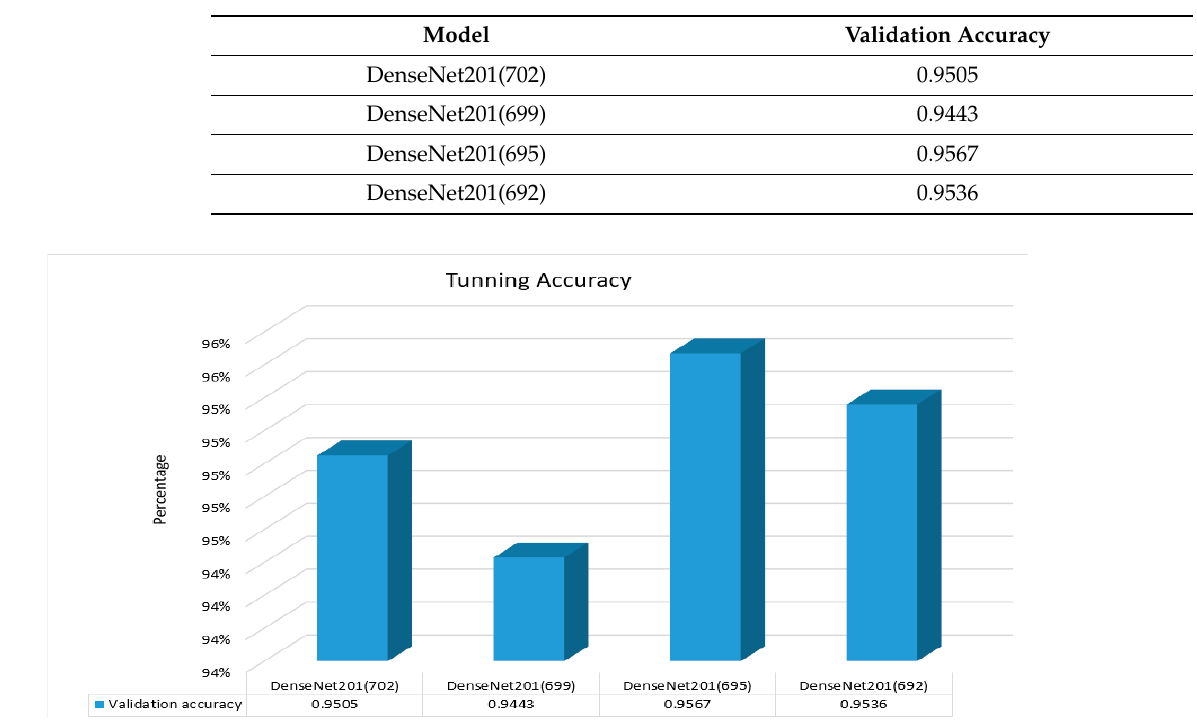
Table 8. DenseNet layers’ accuracy.